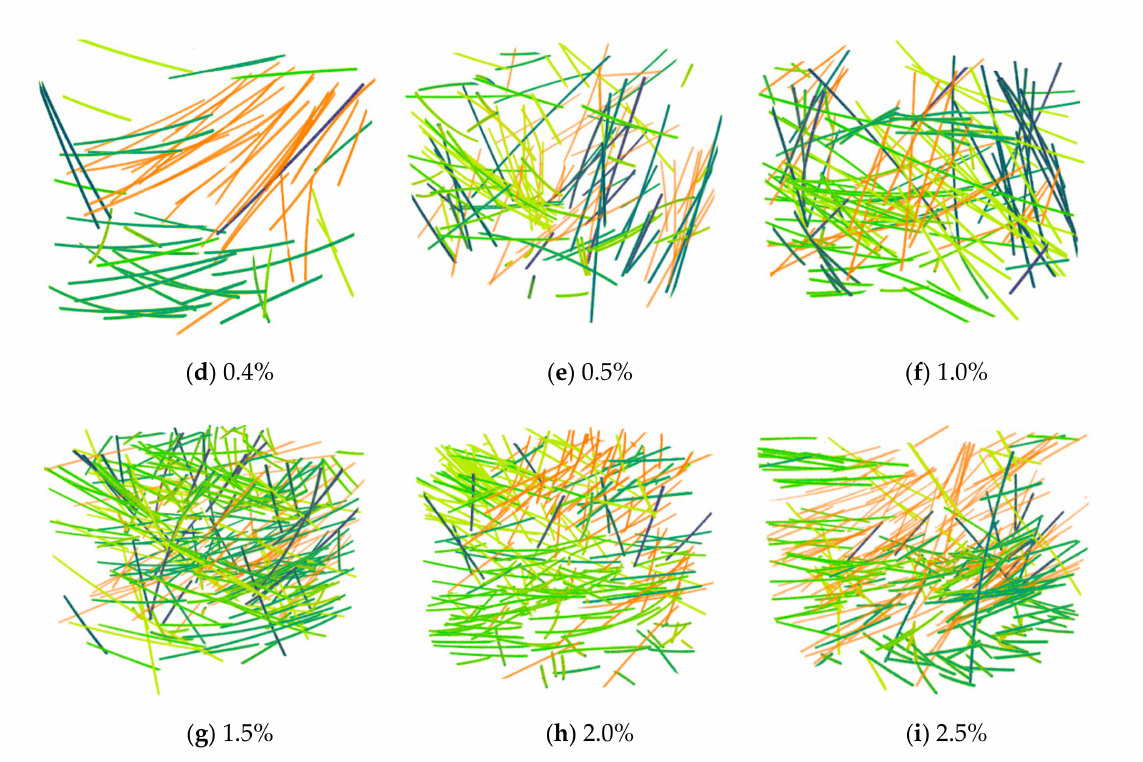
Figure 6. 3D visualization of the orientations of individual fibers in HPFRCC. Each color represents the di ff erent 3D spherical sections cut at 90 ◦ intervals.